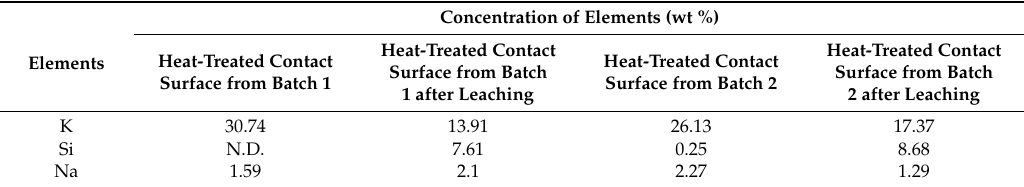
Figure 7. EDS spectra of the entire observed surfaces of the heat-treated products obtained from batch 1 and batch 2 before and after leaching process. Table 4. Concentrations of K, Si and Na on the contact surfaces of the heat-treated products, determined by the entire EDS analysis in FE-SEM.